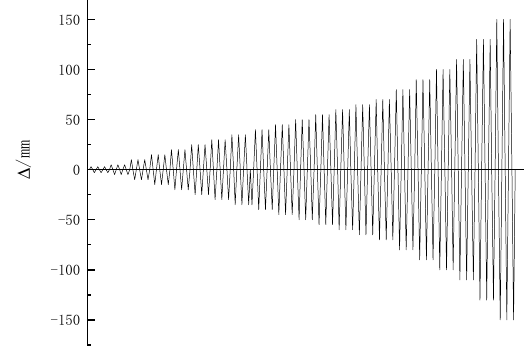
Figure 9. Loading scheme.